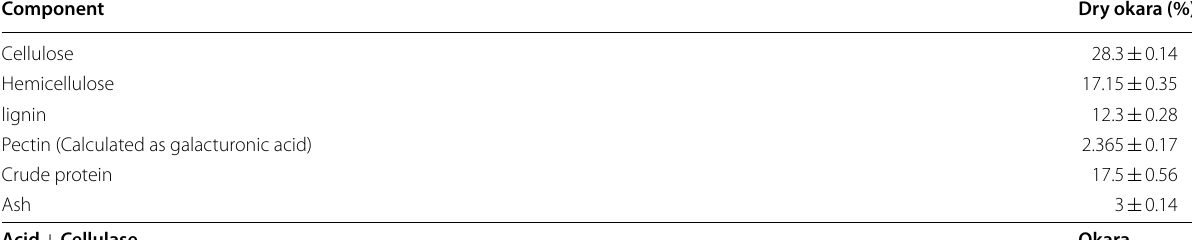
Table 2 Dried okara and okara acid hydrolysate components